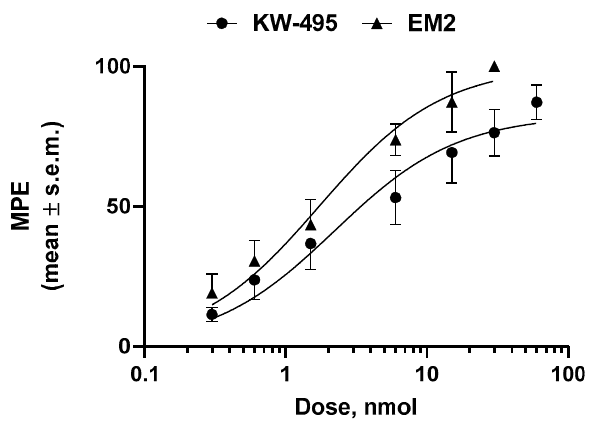
Figure 2. Effect of different doses of KW-495 chimera and EM-2 in the mouse hot-plate test. Results are expressed as percentage (mean ± SEM) of the maximal possible effect (%MPE) for the inhibition of jumping induced by i.t. injection of KW-495 or EM-2. n = 6–10 mice for each experimental